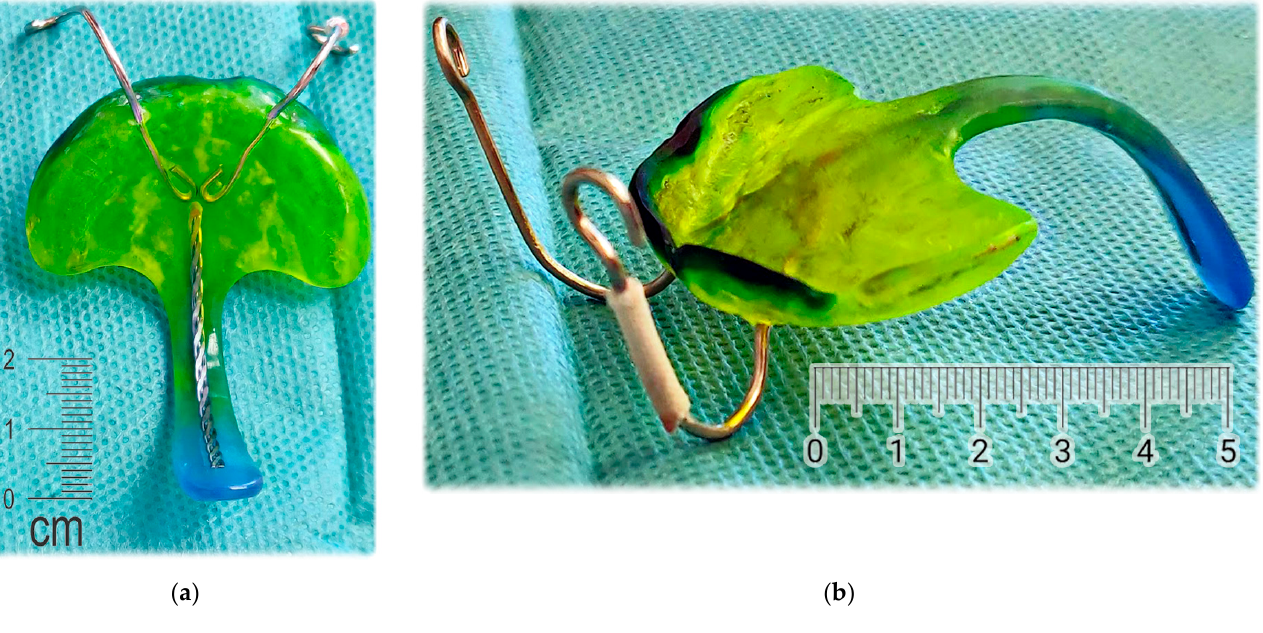
Figure 3. Conventional design of Tübingen Palatal Plate (TPP) made by laboratory technician with metallic hooks for extraoral pull and safety metallic wire in the body of oropharyngeal spur: ( a ) Lingual view; ( b ) Palato-lateral view. Scale is in cm.